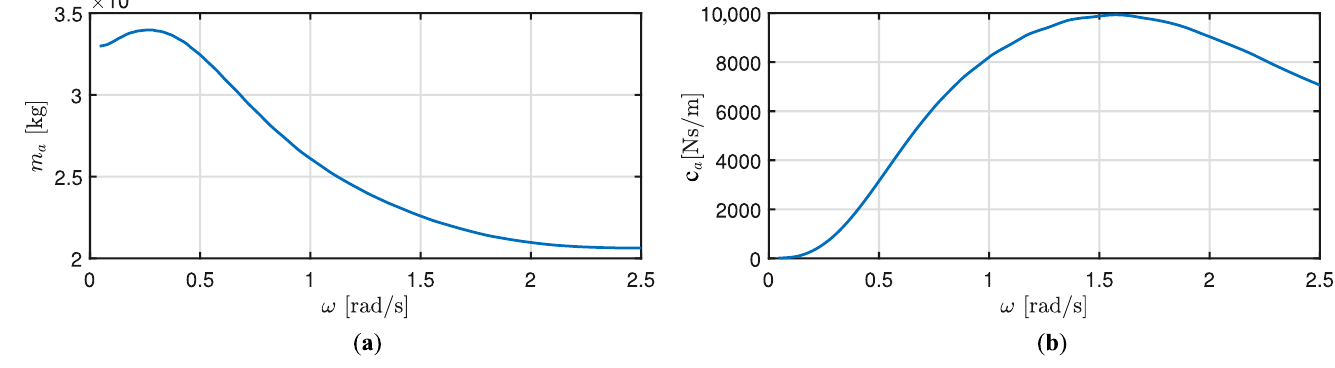
Figure 9. The hydrodynamic coefficients for the ( a ) added mass m a ( ω ) and ( b ) damping c a ( ω )